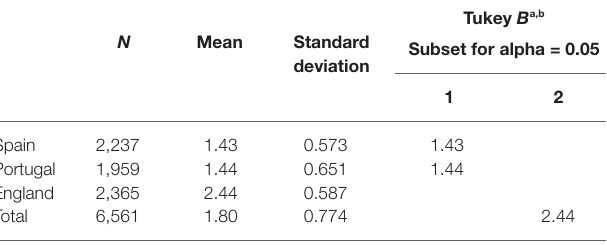
TABLE 4 | Cognitive level by countries and results of Tukey B test.